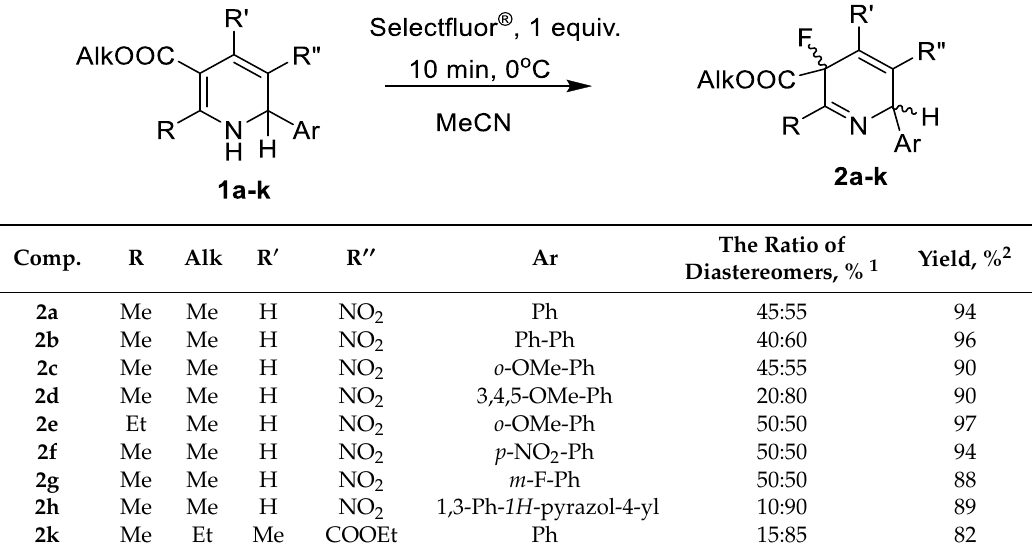
Table 1. The reaction of 1,2-dihydropyridines 1a – k with Selectfluor ® .